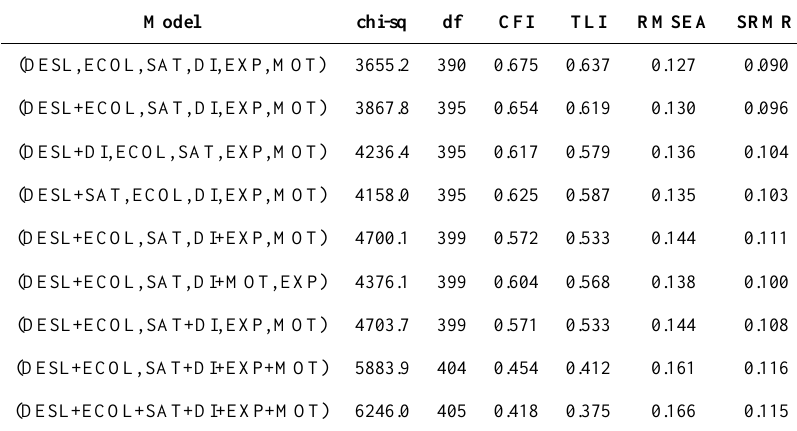
Table 2. Confirmatory factor analysis (n = 522)